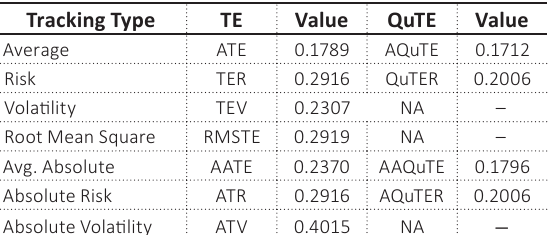
Figure 6. Comparing the benchmark and tracking Table 5. (Quantile) Tracking errors